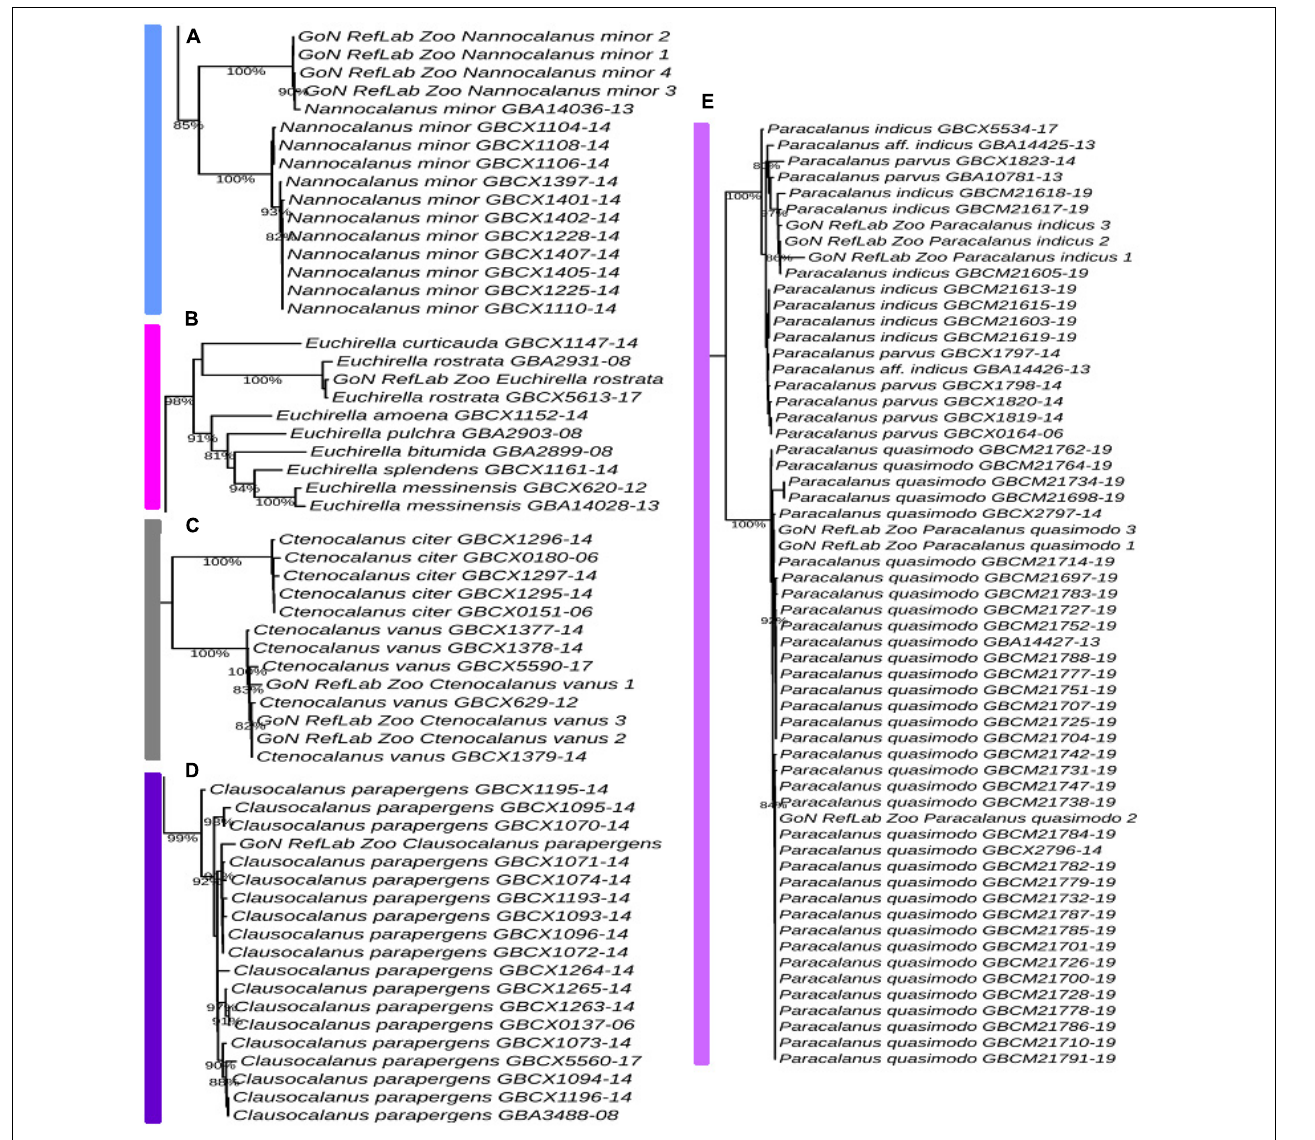
FIGURE 6 | Molecular identification based on ML tree. Portions from the full tree are illustrated: (A) Nannocalanus minor ; (B) Euchirella rostrata ; (C) Ctenocalanus vanus; (D) Clausocalanus parapergens ; (E) Paracalanus parvus. Full tree available in Supplementary Figure 1